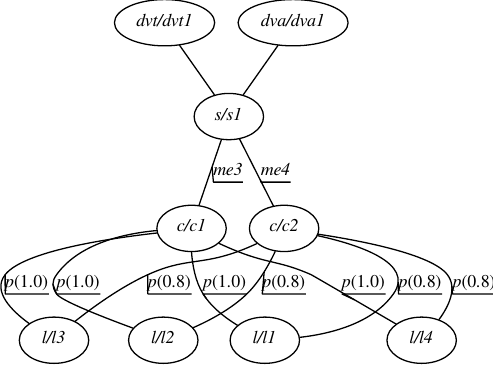
Figure 6. A street segment, logical model: CAG Ψ , based on the Ψ (structure) grammar.